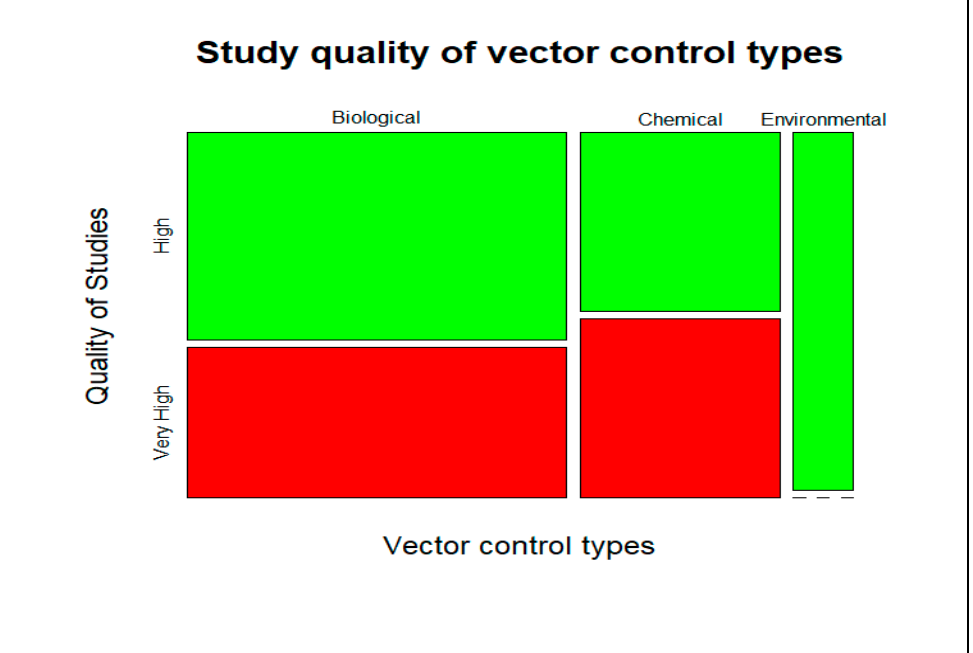
Figure 4. Mozaic plot showing the distribution of the bounded area of study quality of the vector control types.